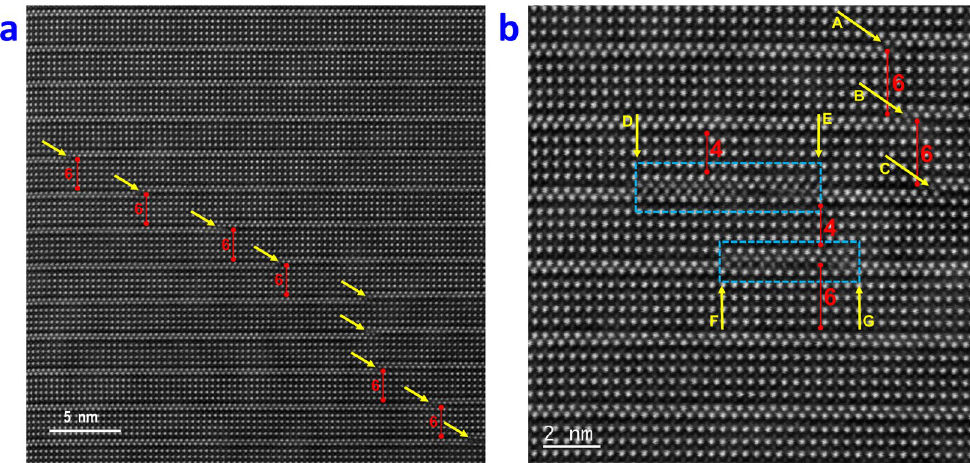
Figure 4. Representative atomic resolution images of B6TFMO in a region of the crystallite displaying OPBs/ stacking faults. HAADF-STEM images of (a) lower magnification for B6TFMO-A and (b) higher magnification for B6TFMO-B. The numbers displayed in red designate the number of PK layers (m) in the region designated by the red bar. The majority of the sample has an m = 5 structure. Yellow arrows demonstrate the position of the OPBs and blue rectangles indicate stacking fault